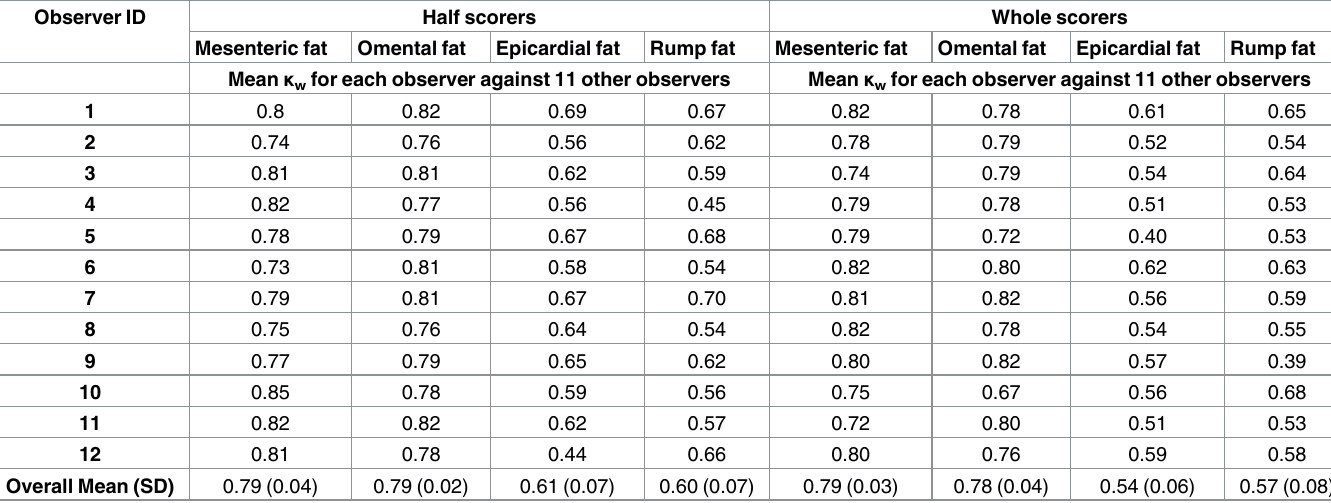
Table 4. Inter-observer agreementof the EQUIFAT scores.